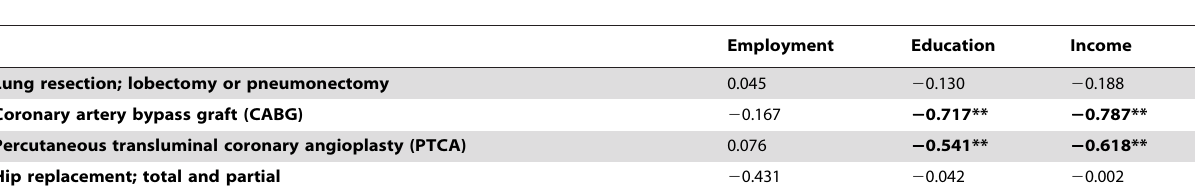
Table 3. Relationship between individual socioeconomic variables and the prevalence of different procedures.